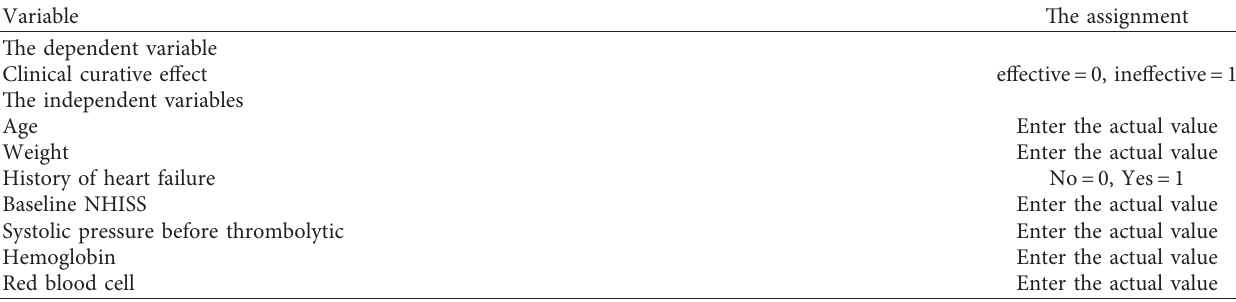
Table 4: Variable assignment of risk factors affecting the efficacy of intravenous thrombolysis with alteplase in ICS combined with atrial fibrillation.